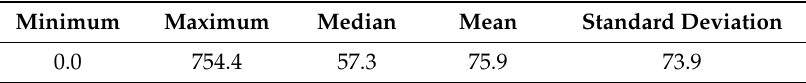
Table 1. Primary statistics of annual EUI (kBtu / ft 2 ) in the